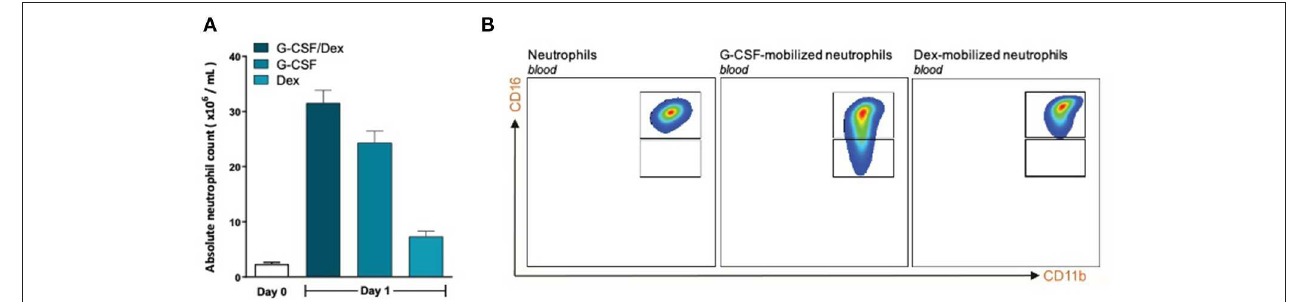
FIGURE 3 | G-CSF- and Dex-mobilized donors have an increased amount of neutrophils consisting mostly of mature neutrophils. (A) Absolute neutrophil count of peripheral blood of healthy donors (white bar, n = 6) or from G-CSF/Dex-treated, G-CSF-treated or Dex/treated donors 1 day after administration ( n = 3). (B) Surface marker expression of CD11b and CD16 was measured by flow cytometry analysis of neutrophils from blood of healthy donors (left panel), G-CSF-mobilized neutrophils (center panel) and Dex-mobilized neutrophils. Shown are representative FACS analysis images ( n = 3).